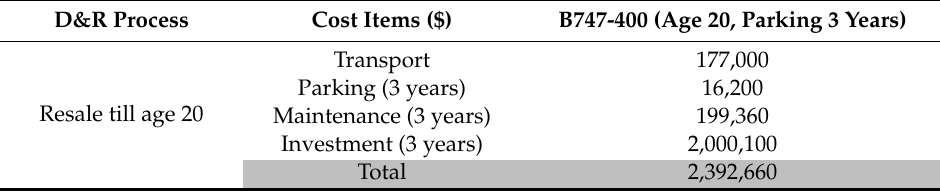
Table 9. Disposal and recycle costs for 747-400 resale till age 20 (2005